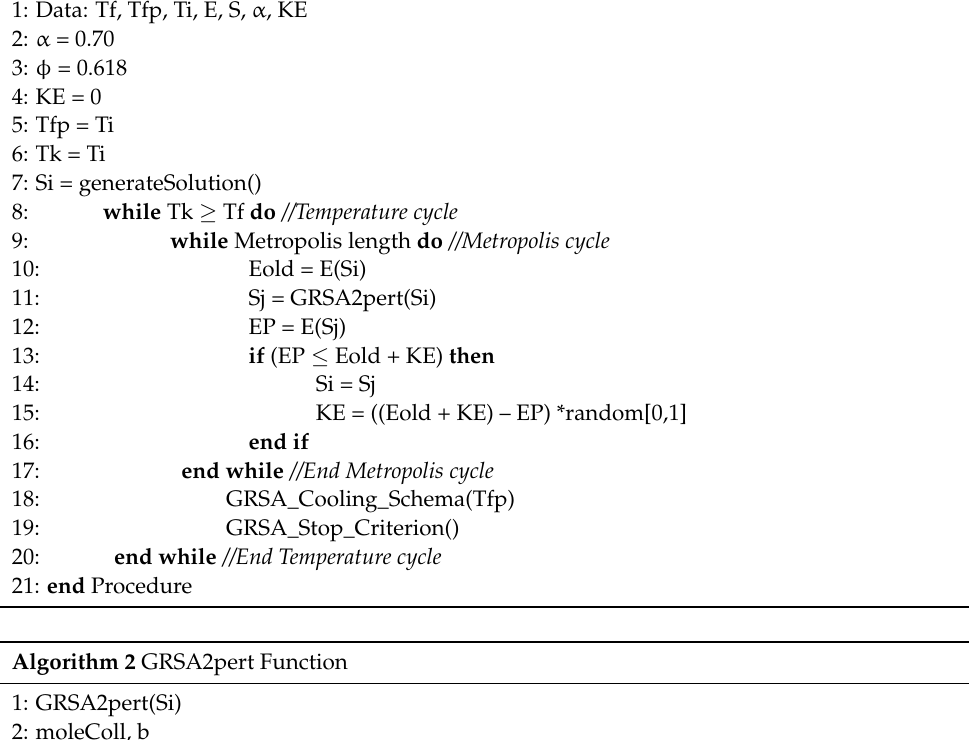
Algorithm 1 GRSA2 algorithm Procedure